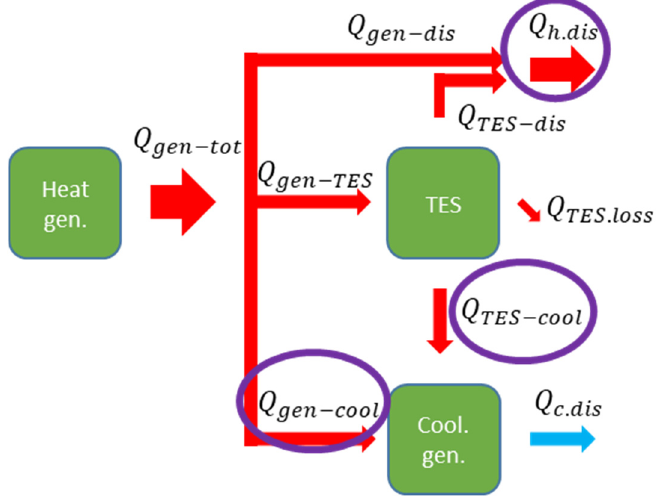
Figure 3. Generic heat fluxes (Highlighted are the fluxes used for the ponderation ratio) [18].